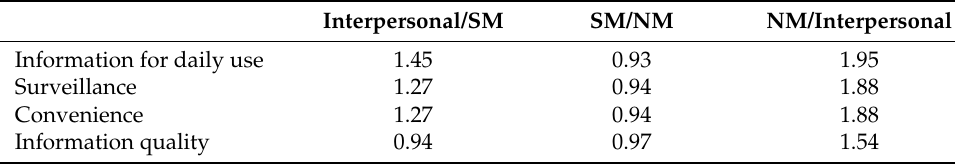
Table 4. Niche overlap among the three types of